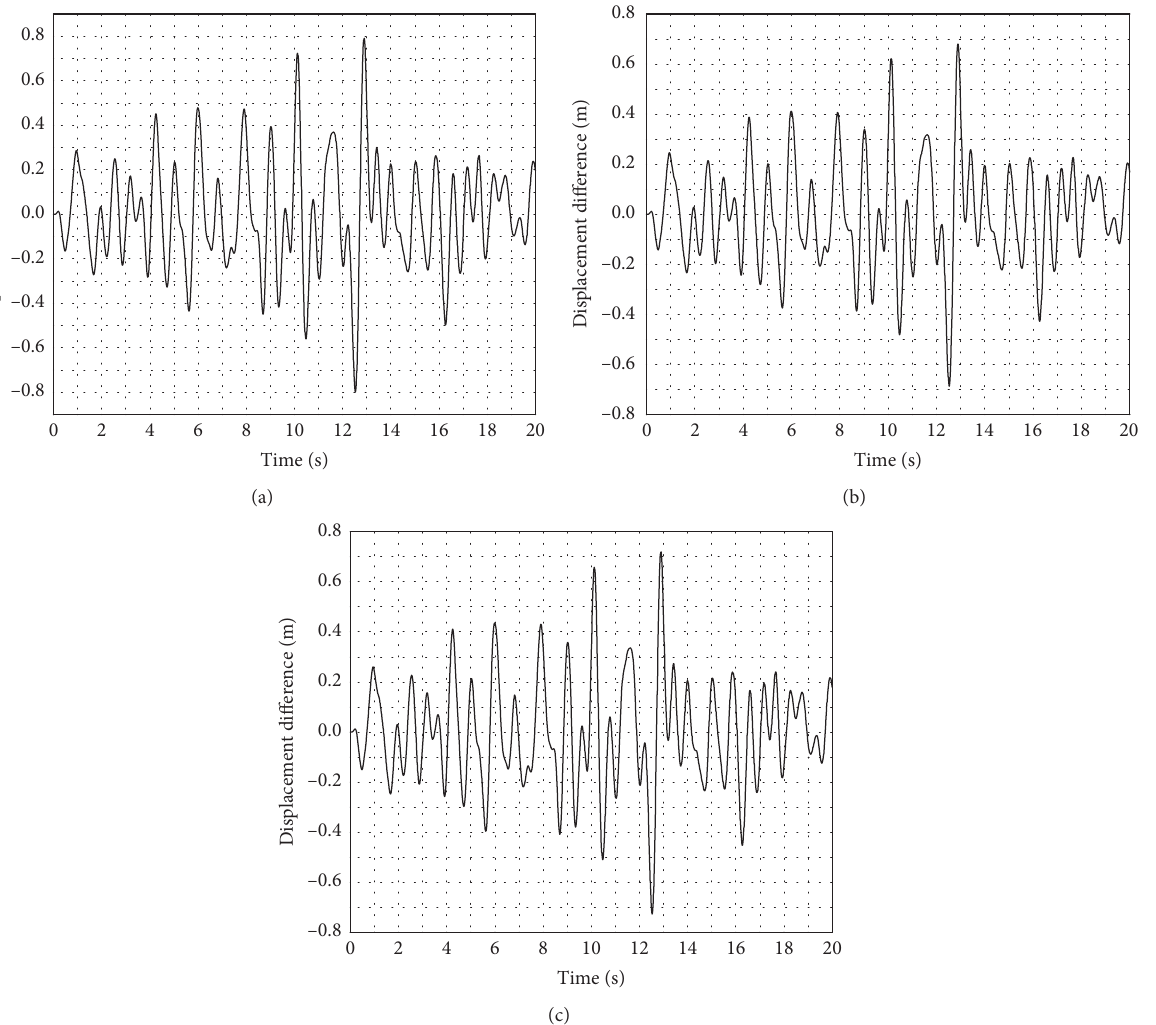
Figure 11: Displacement responses of the tunnel roof. (a) Without seismic measures. (b) With shock absorption layers. (c) With seismic